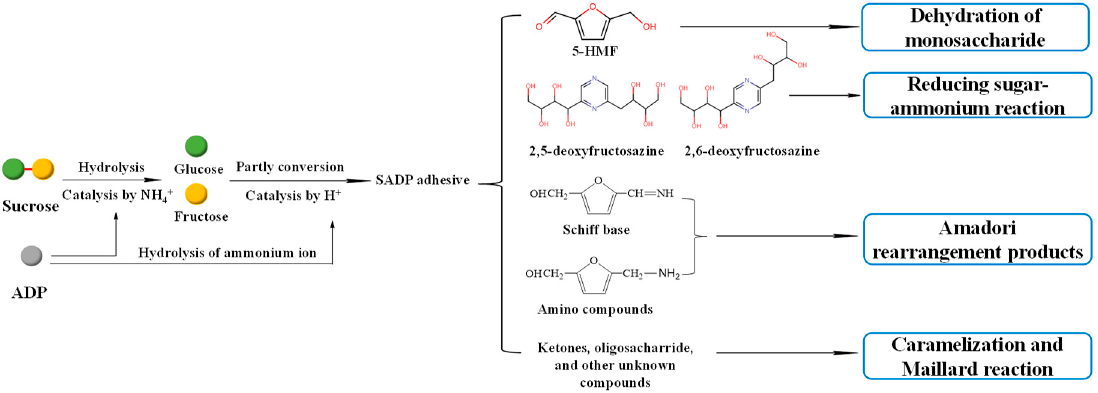
Figure 2. Possible synthesis mechanism of SADP adhesive.